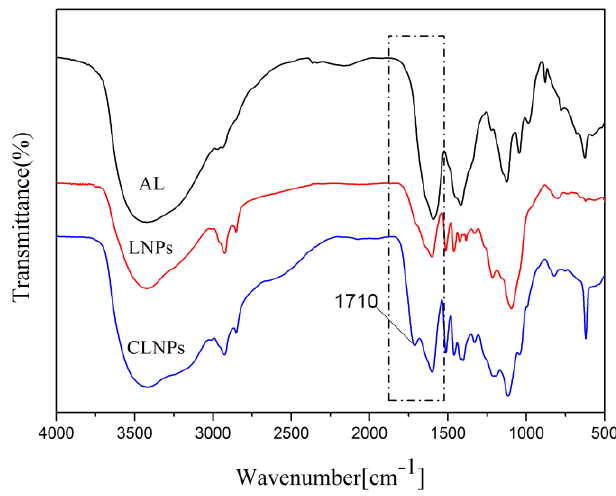
Figure 3. IR spectra of AL, lignin nanospheres (LNPs), and CLNPs.